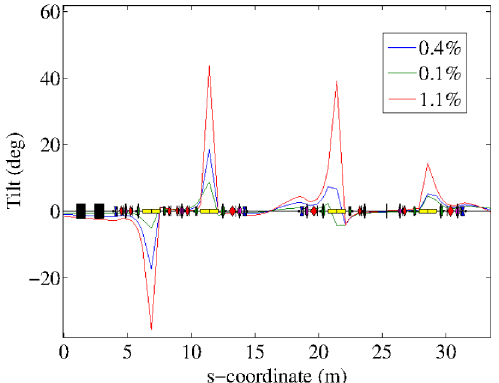
FIG. 1. Beam tilt angle for three different settings of the skew quads at ALBA in Sector